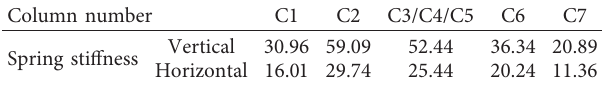
Table 2: Stiffness of spring isolated device (kN/mm). Column